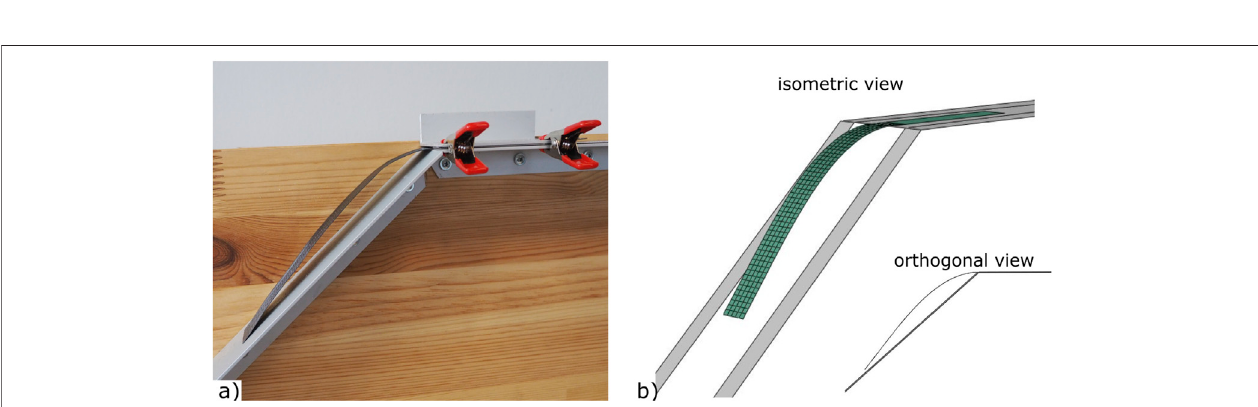
FIGURE 1 | Illustration of the localized shear band within a 10 ° off-axis test sample, recorded with the Aramis DIC system.